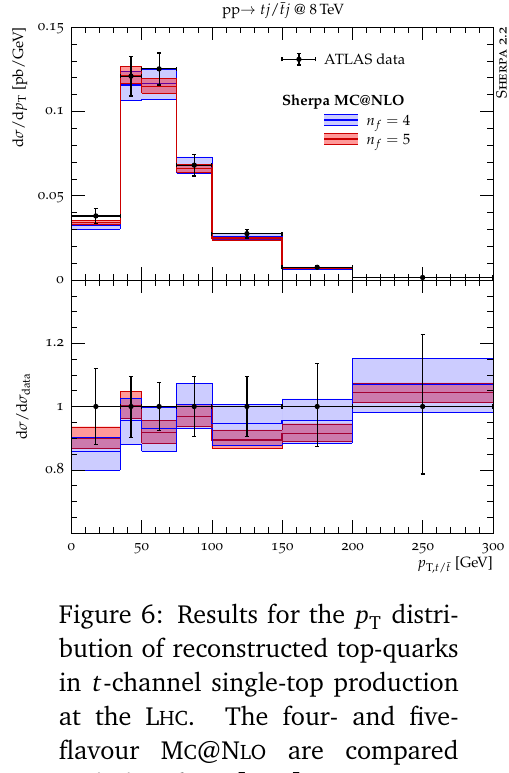
dis- Figure 6: Results for the p T bution of reconstructed top-quarks in t -channel single-top production at the L HC . The four- and five- flavour M C @N LO are compared with data from [ 182 ]